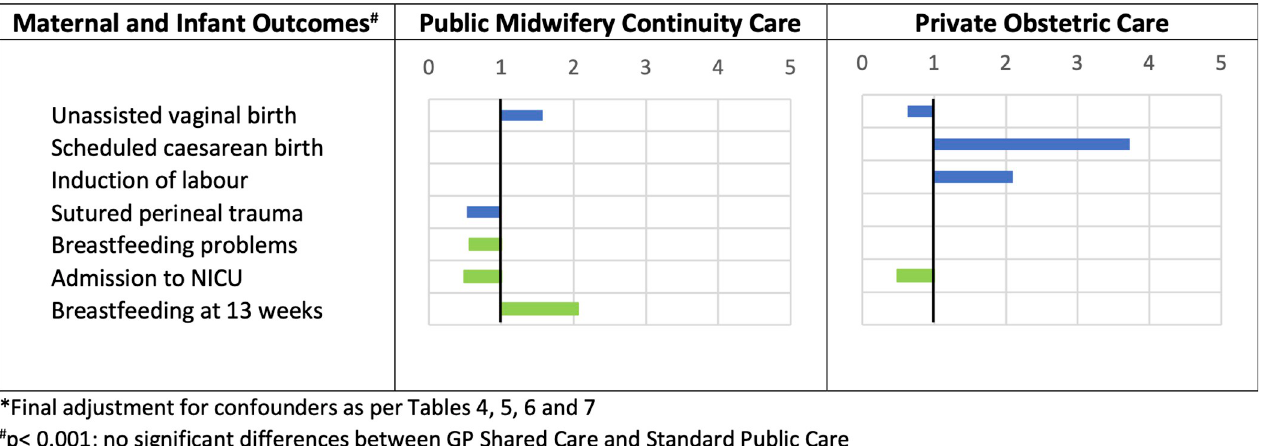
Fig 1. Adjusted odds � of maternal and infant outcomes significantly different to Standard Public Care # . Green indicates improved outcomes, red indicates poorer outcomes and blue indicates outcomes with differential value dependent on consumer needs and preferences.